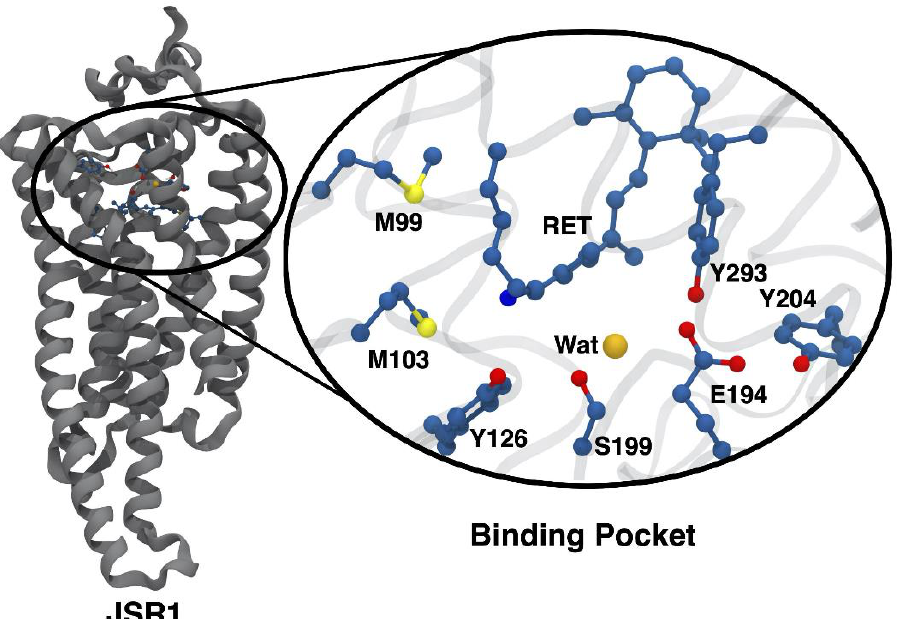
Figure 1. Crystal structure of jumping spider rhodopsin-1 (JSR1), containing the 9- cis form of retinal, taken from the Protein Data Bank (PDB ID: 6I9K) [7]. Several key residues in the retinal-binding pocket are also shown. These include the counterion E194 and a crystallographic water thought to be important to the hydrogen bonding network linking the RPSB.